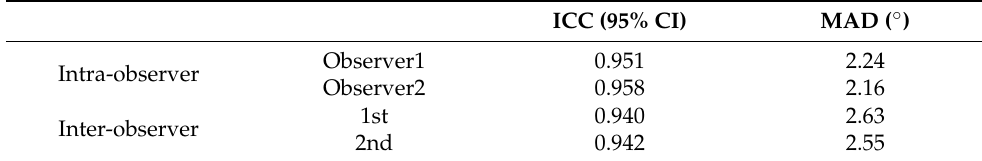
Table 3. Comparison of detection results of spinal key points.